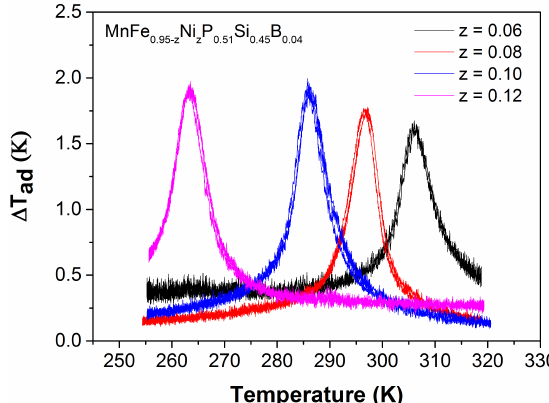
Figure 14. Temperature dependence of the adiabatic temperature change obtained by direct measurements for a magnetic field change of ∆ B = 1.1